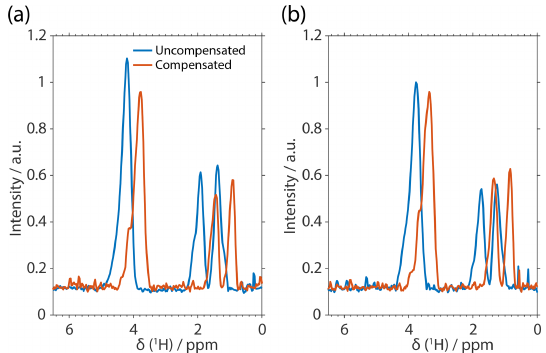
Figure 6. Experimental spectra of FSLG-based decoupling on nat- ural abundance glycine. The spectra are not processed in terms of chemical-shift scaling and referencing to illustrate the effect of im- plementing compensated pulses. The effective-field angle was ei- ther set to the magic angle (a) or 60 ◦ (b) . The shift in resonance frequencies between the uncompensated pulses (blue) and the com- pensated (red) can be attributed to additional effective fields caused by pulse transients. The MAS frequency was set to 14kHz with an effective field of 125kHz at an external magnetic field of